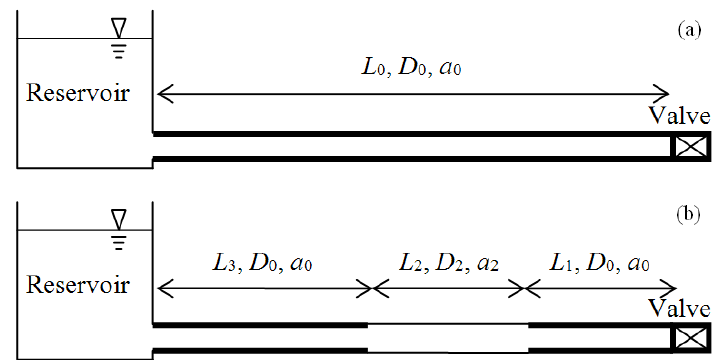
Figure 1. Schematic of reservoir, pipe and valve system for ( a ) an intact, fault free pipeline and ( b ) a pipeline with a section of reduced wall thickness.